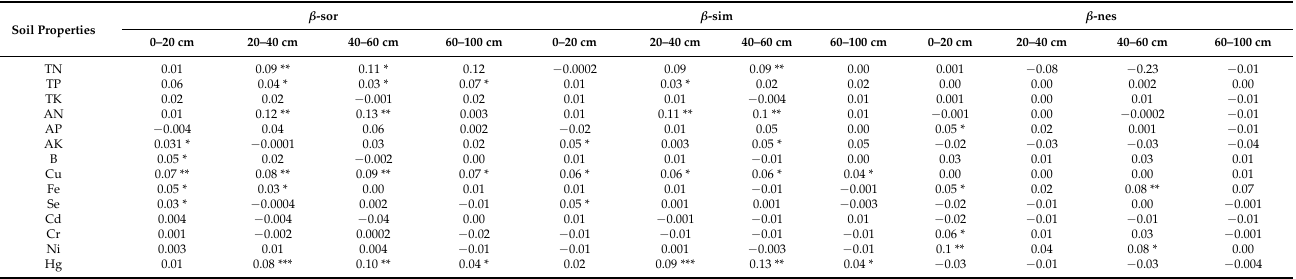
Figure 5. Sum of I-spline coefficients for environmental factors on β -diversity of trees ( a ), shrubs ( b ) and herbs ( c ). environmental factors included geographical distance (Dist), altitude (Alt), Boron (B), Molybdenum (Mo), Manganese (Mn), Zinc (Zn), Cuprum (Cu), Ferrum (Fe), Selenium (Se), Cadmium (Cd), Plumbum (Pb), Chromium (Cr), Nickel (Ni), Hydrargyrum (Hg) and Arsenic (As), Total nitrogen (TN), Total phosphorus (TP), Total kalium (TK) and Available nitrogen (AN), Available phosphorus (AP), Available kalium (AK). Table 2. The coefficients of Pearson correlation between β -diversity components of trees and soil factors of different depths.